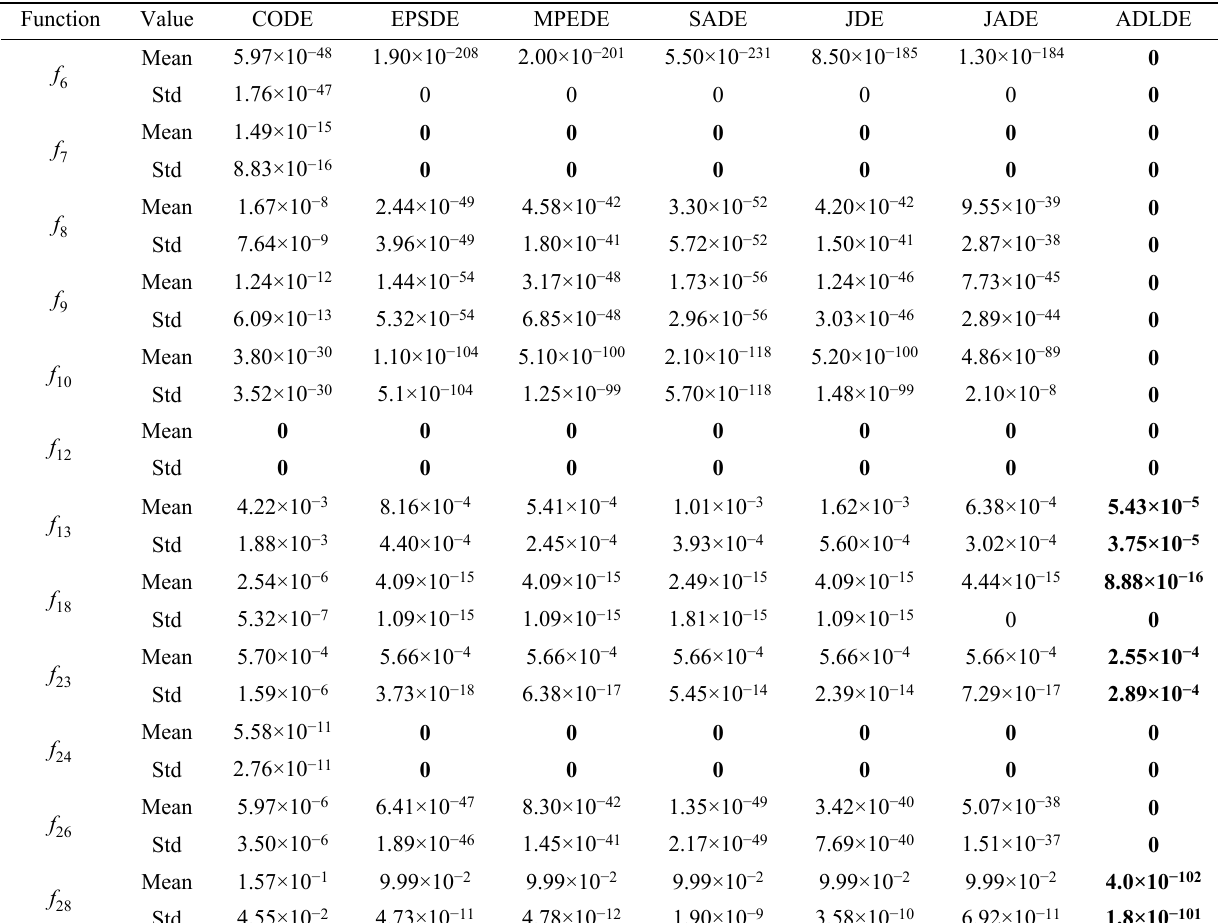
Table 4 Function error values of benchmark functions when D =